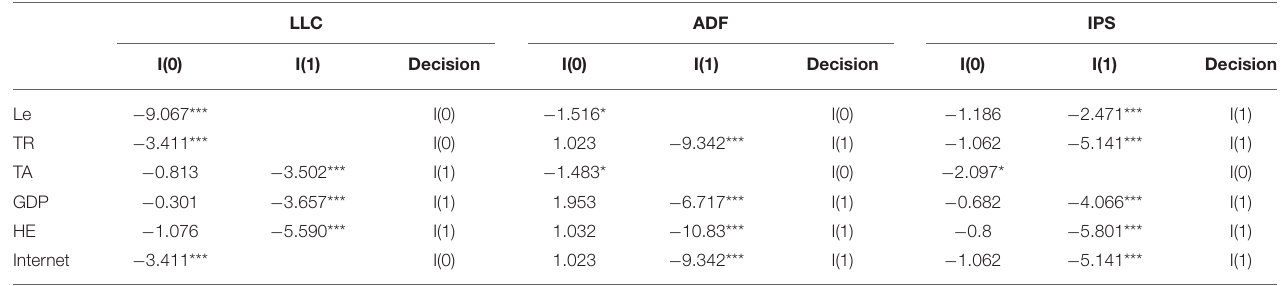
TABLE 3 | Panel unit root testing.